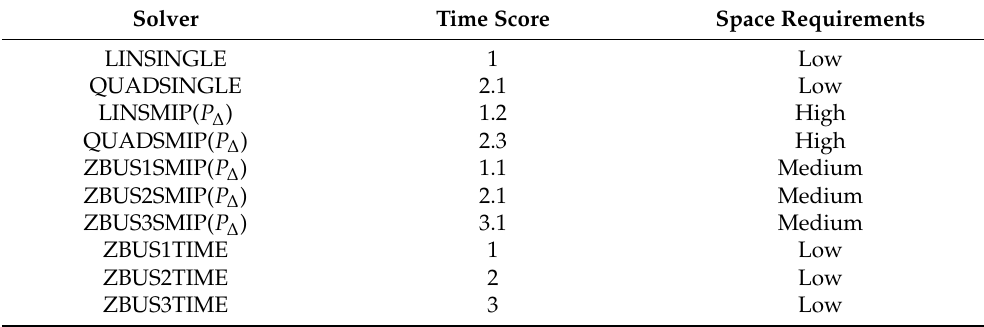
Table 2. Relative score of computational time and space requirements for each power flow method.